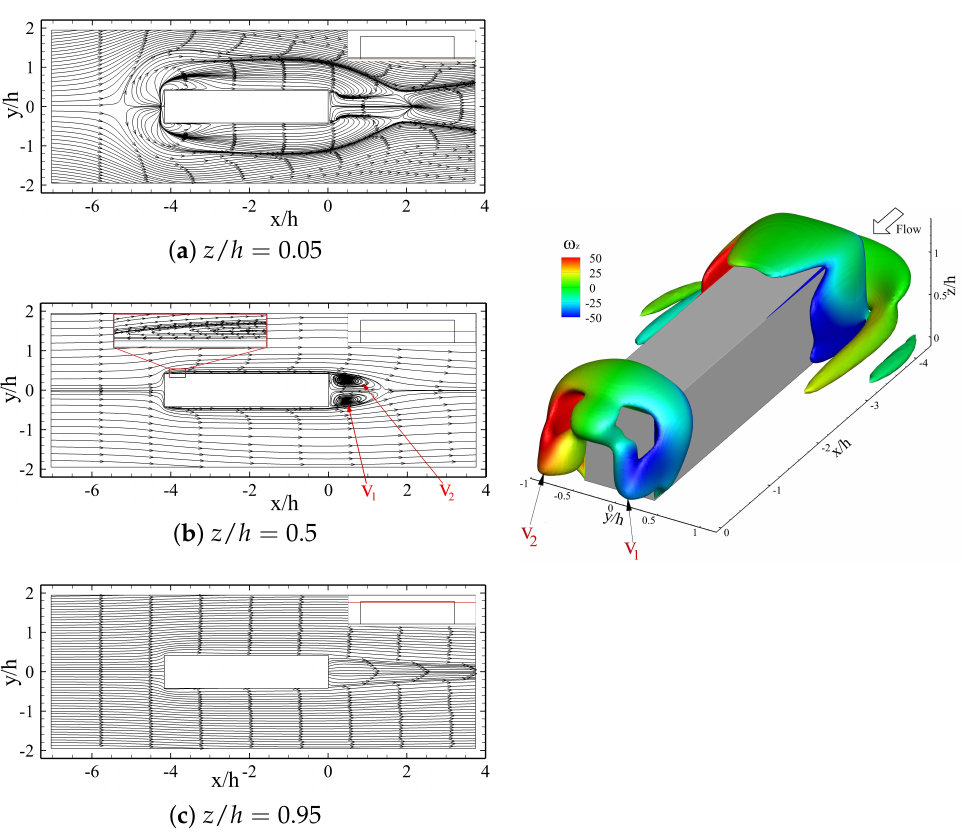
Figure 16. Isosurface of Q ∗ = 4.42 × 10 − 2 overlaid by the contour of z -component of vorticity and top view of the wake structure for the long prism.